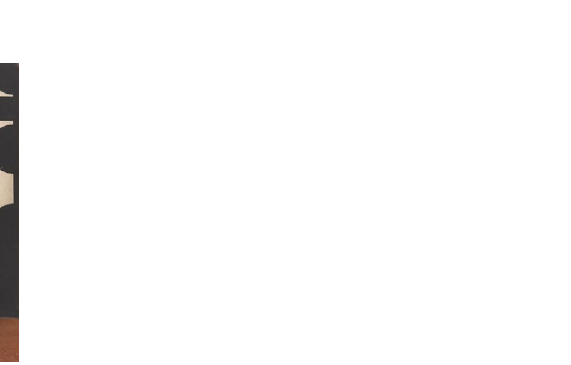
Figure 11. Radiation pattern of fabricated antenna-1 at f 1 = 8.7 GHz (red), f 2 = 9.55 GHz (blue), and f 3 = 10 GHz (green); φ = 0 (left), φ = 90 ◦ (right).